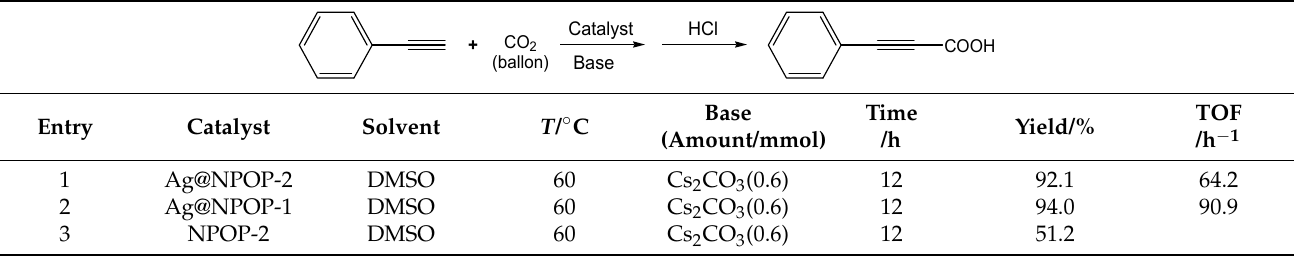
Table 2. Catalysis of NPOPs and Ag@NPOPs for the carboxylation of phenylacetylene with CO 2 a .